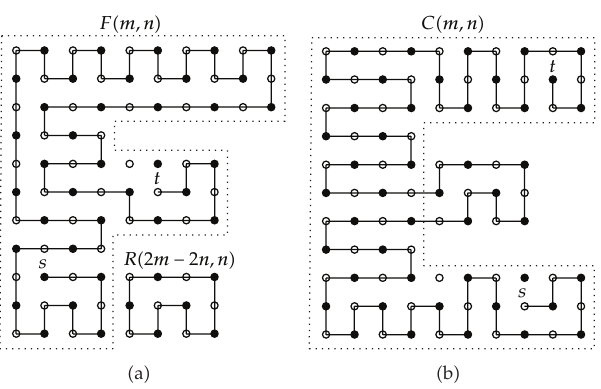
Figure 10: E -alphabet grid graphs in which there is no Hamiltonian path between s and t